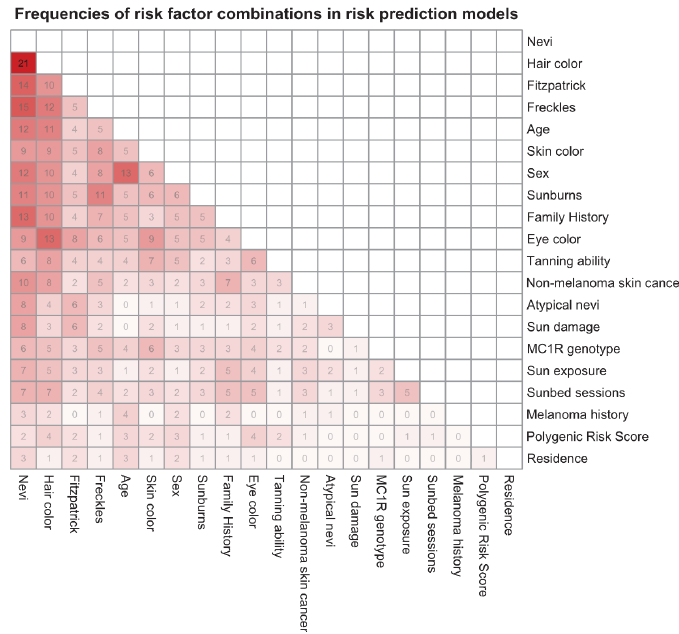
Figure 4. Heatmap indicating joint occurrences of risk factor pairs in risk prediction models for melanoma. Only risk factors occurring in more than two risk prediction models are included. Each number represents the absolute frequency of the corresponding risk factor combination. The darker the field the more frequent is the corresponding risk factor combination ( n = 45 models). MC1R = melanocortin 1 receptor.